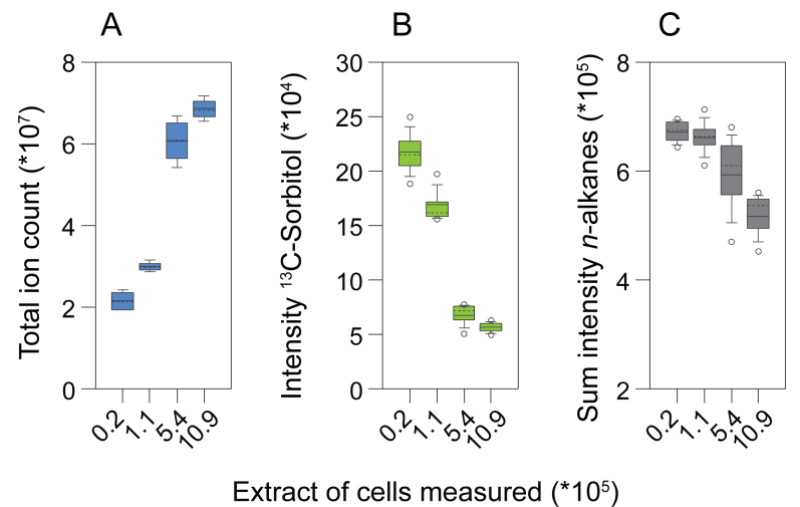
Figure 3. The effect of matrix complexity on metabolite profile properties. ( a ) Total ion count; ( b ) the response of the internal standard, 13 C-sorbitol; and ( c ) the summed intensities of n -alkanes obtained by analyzing different amounts of